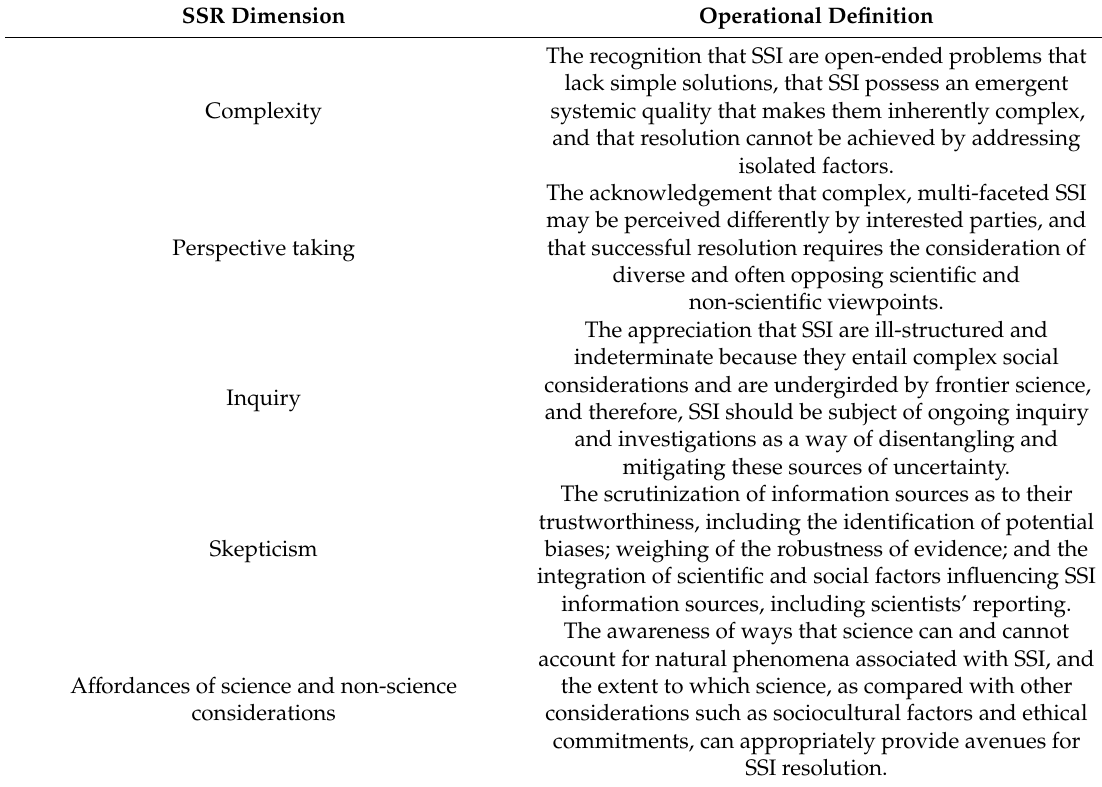
Operational definitions of each dimension of socio-scientific reasoning (SSR) (adapted from [16] p.